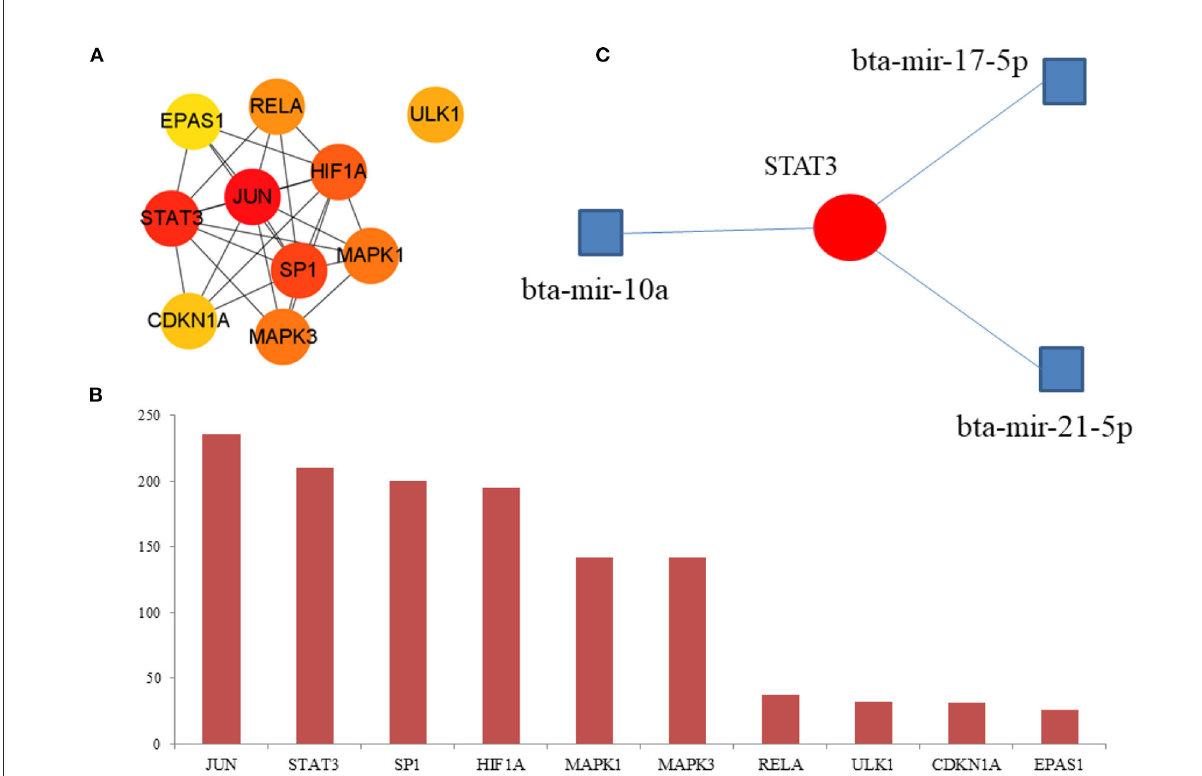
FIGURE7 Hub DE-FRGs and miRNA. (A) Network of the top 10 hub DE-FRGs. (B) The rank of the hub DE-FRGs. (C) Prediction of the